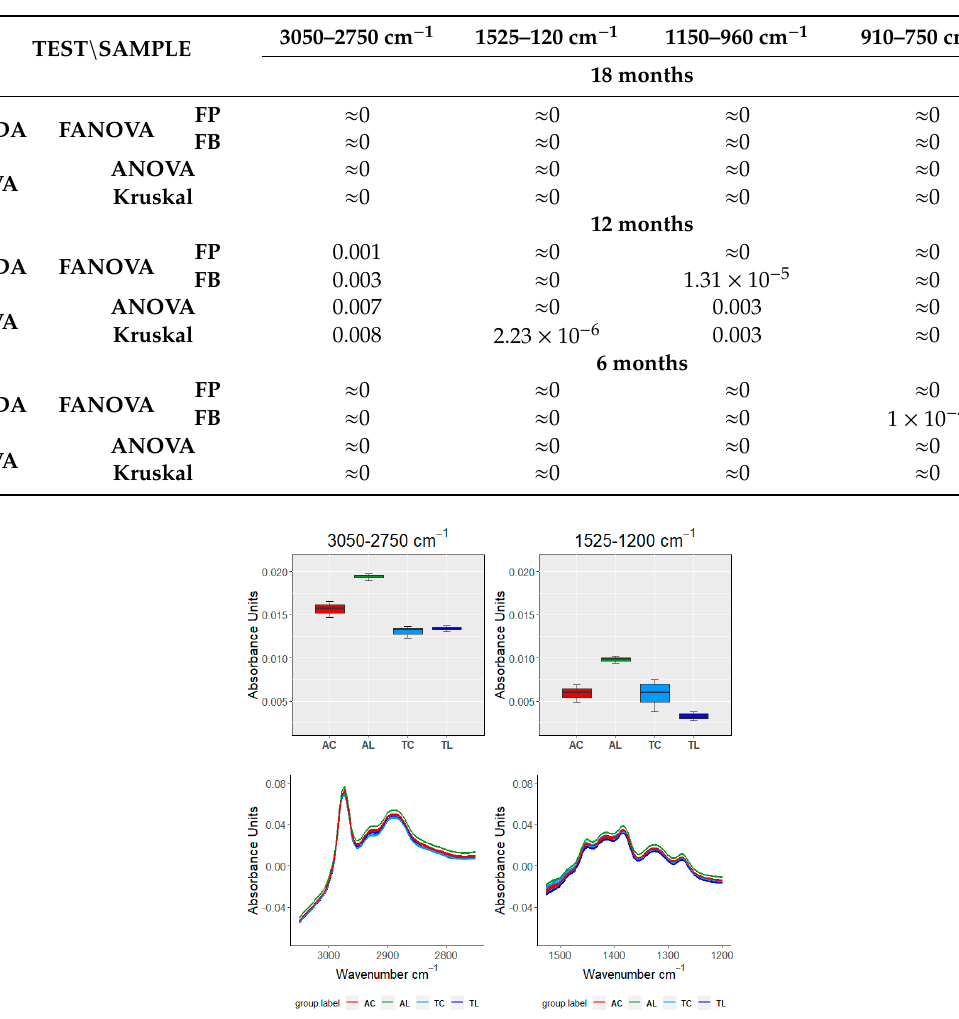
Table 4. Numerical results of the similarity contrast between the groups AC, AL, TC, and TL, depending on the ageing time of the wine spirit samples. Functional results (FDA) are based on FANOVA using two di ff erent tests (FP: permutation test based on a representation of the base function, FB: F test with a reduced bias estimation method). In addition, the results of the ANOVA and Kruskal’s test representing the vectorial results (VA) are shown. All the results are p -values based on a 5% significance level.